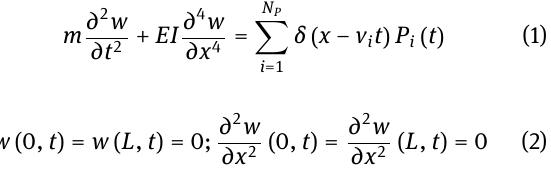
Omit the shearing deformation and moment of